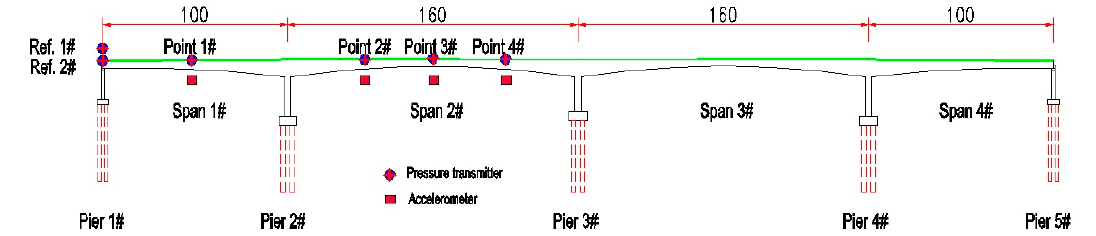
Figure 14 . Deployment of the liquid level sensing system (LLSS). Figure 14. Deployment of the liquid level sensing system